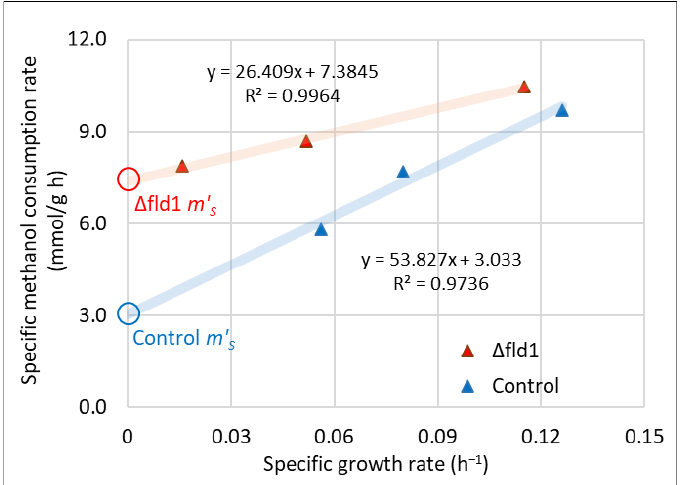
Figure 4. Correlation between the specific consumption rate of methanol ( q S ) and the specific growth rate ( µ ) for control (blue) and Δ fld1 (red) stains. The apparent maintenance coefficient m’ S was estimated from Equation (6). Control: blue open circle; Δ fld1 strain: red open circle.